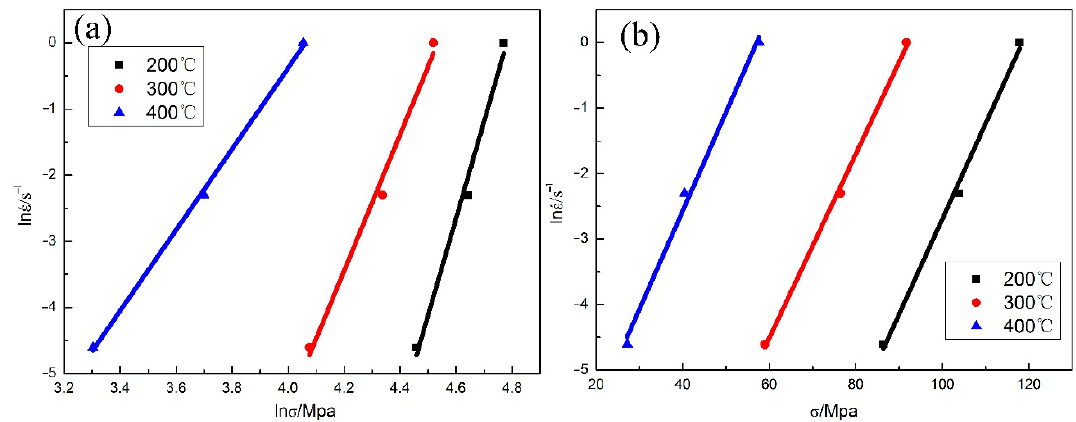
Figure 3. The linear relationship fitting at peak stress: ( a ) lnέ − lnσ and ( b ) lnέ − σ . Zener and Hollomon proposed and verified that in the isothermal deformation process of materials, the function relationship between temperature and deformation rate can be expressed by the Z-parameter, which is presented as: